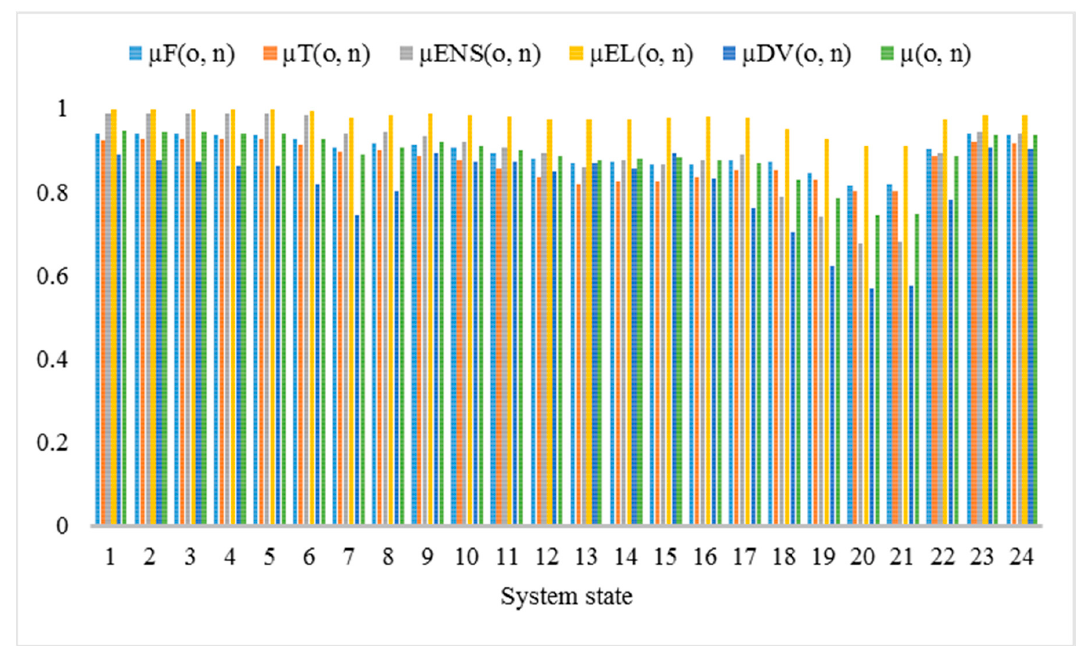
Figure 4. Fuzzy membership functions and overall membership function after NR.